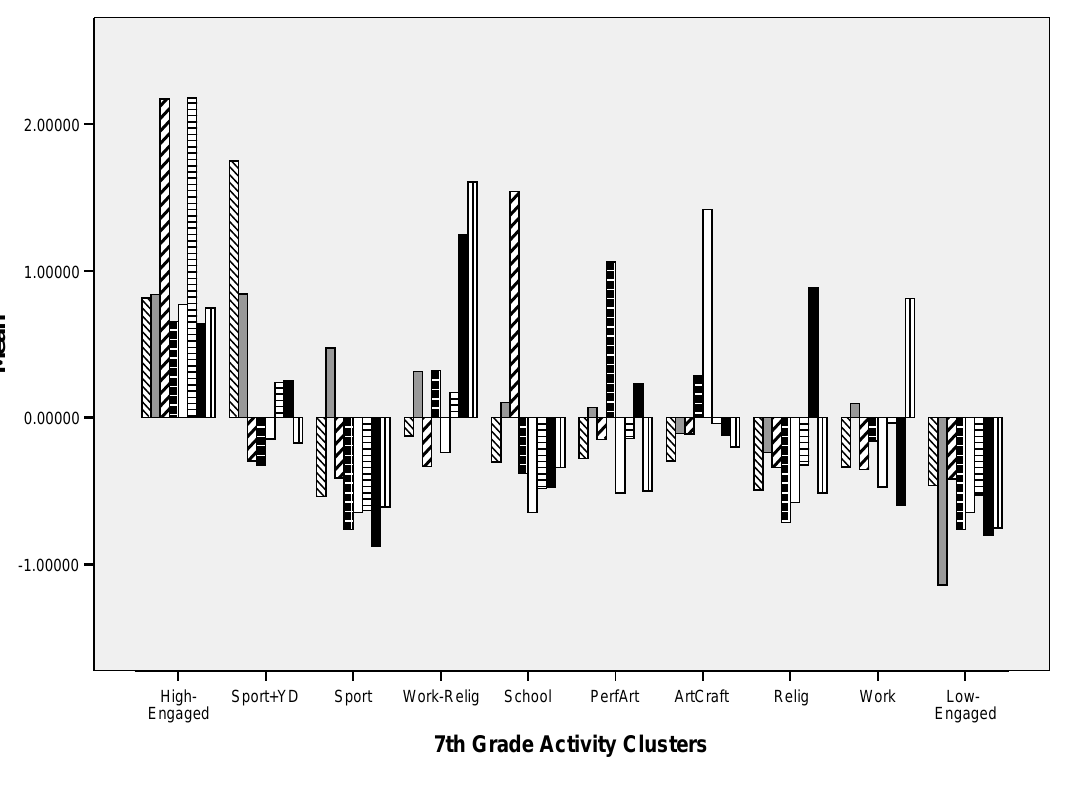
Youth 7 th Grade Activity Participation